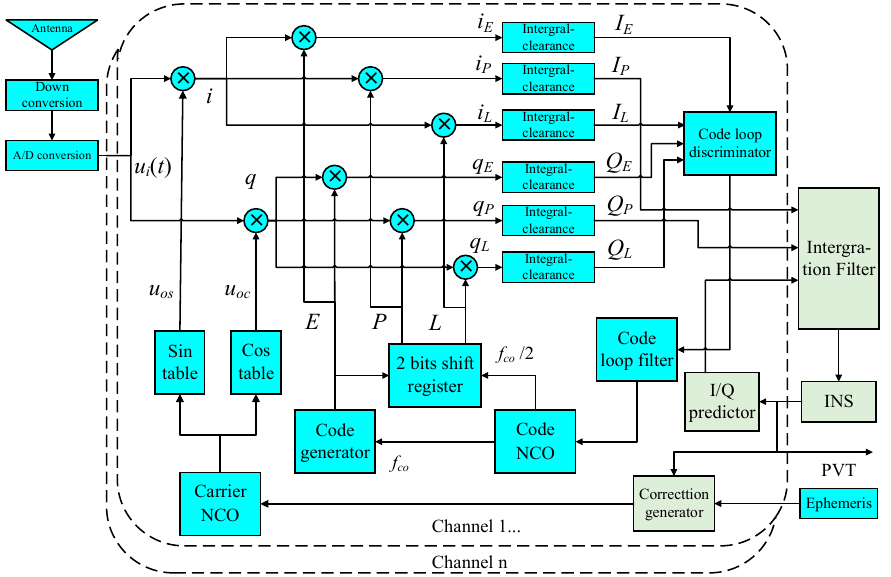
Figure 1. Centralized ultra-tight integration system based on scalar code loops.